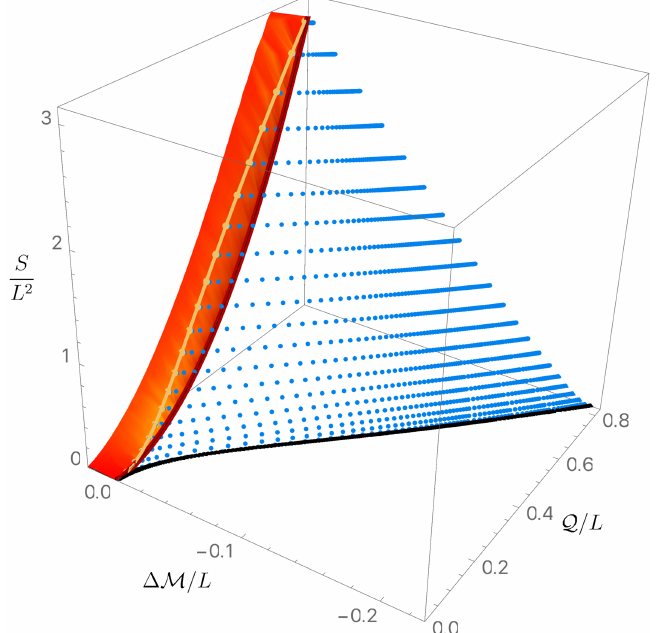
Figure 12 . Entropy as a function of the quasilocal charge and mass difference for Einstein theory with a scalar field charge e = 2 . 3 ( e > e ) in a Minkowski box. When they coexist with RN S BHs, for a given ( Q , M ) /L , hairy BHs always have more entropy than RN, i.e. they dominate the microcanonical ensemble. For e > e , the zero entropy limit of the hairy BH is the soliton (black S disk curve) in the sense that they have the same ( Q , M ) /L as the soliton (the temperature and horizon curvature